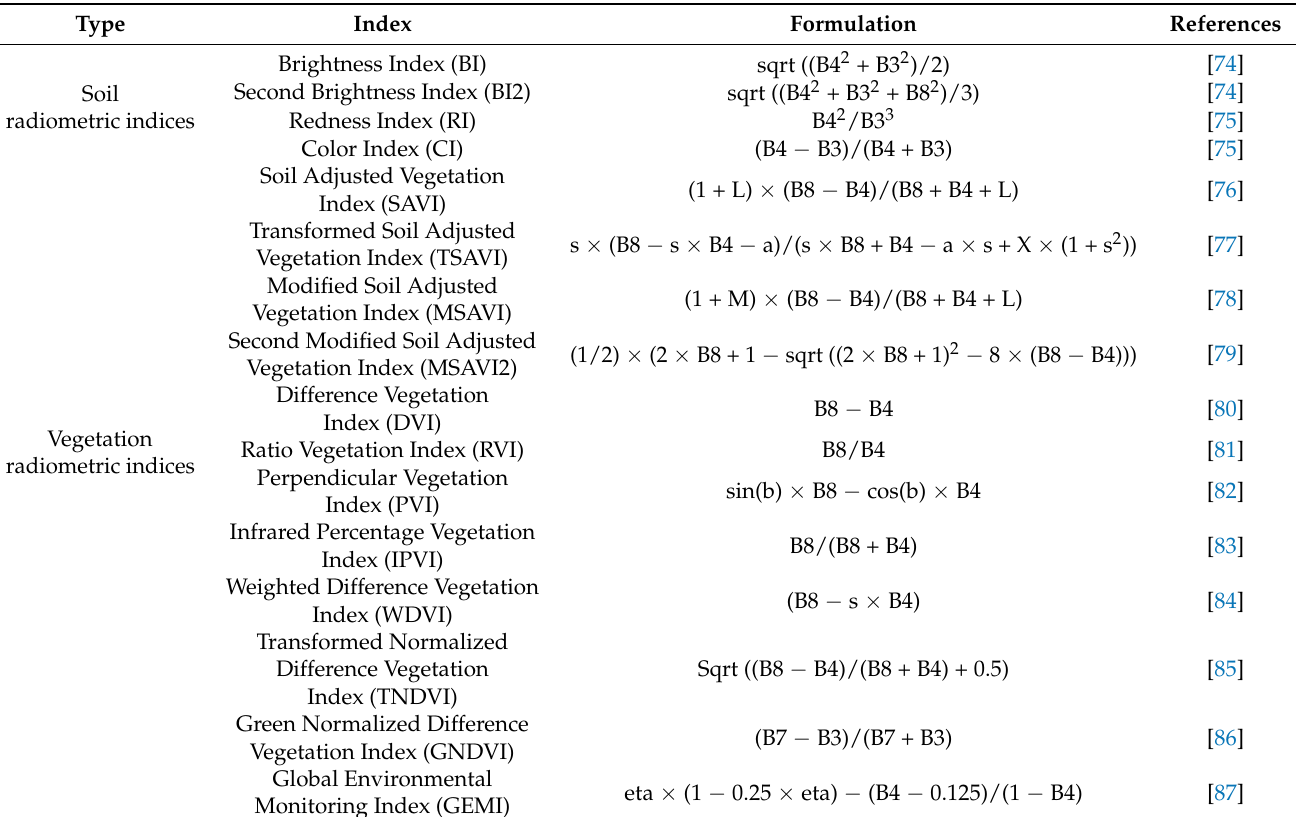
Table A1. Soil radiometric indices and vegetation radiometric